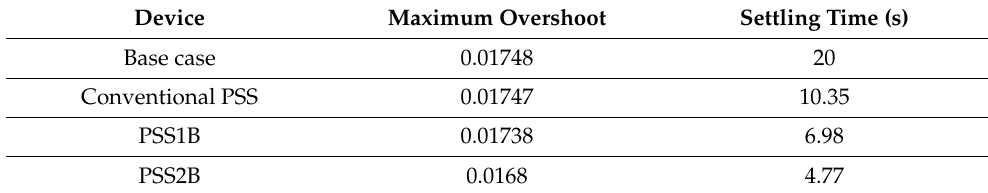
Table 15. Maximum overshoot and settling time of rotor angle deviation at heavy loading.